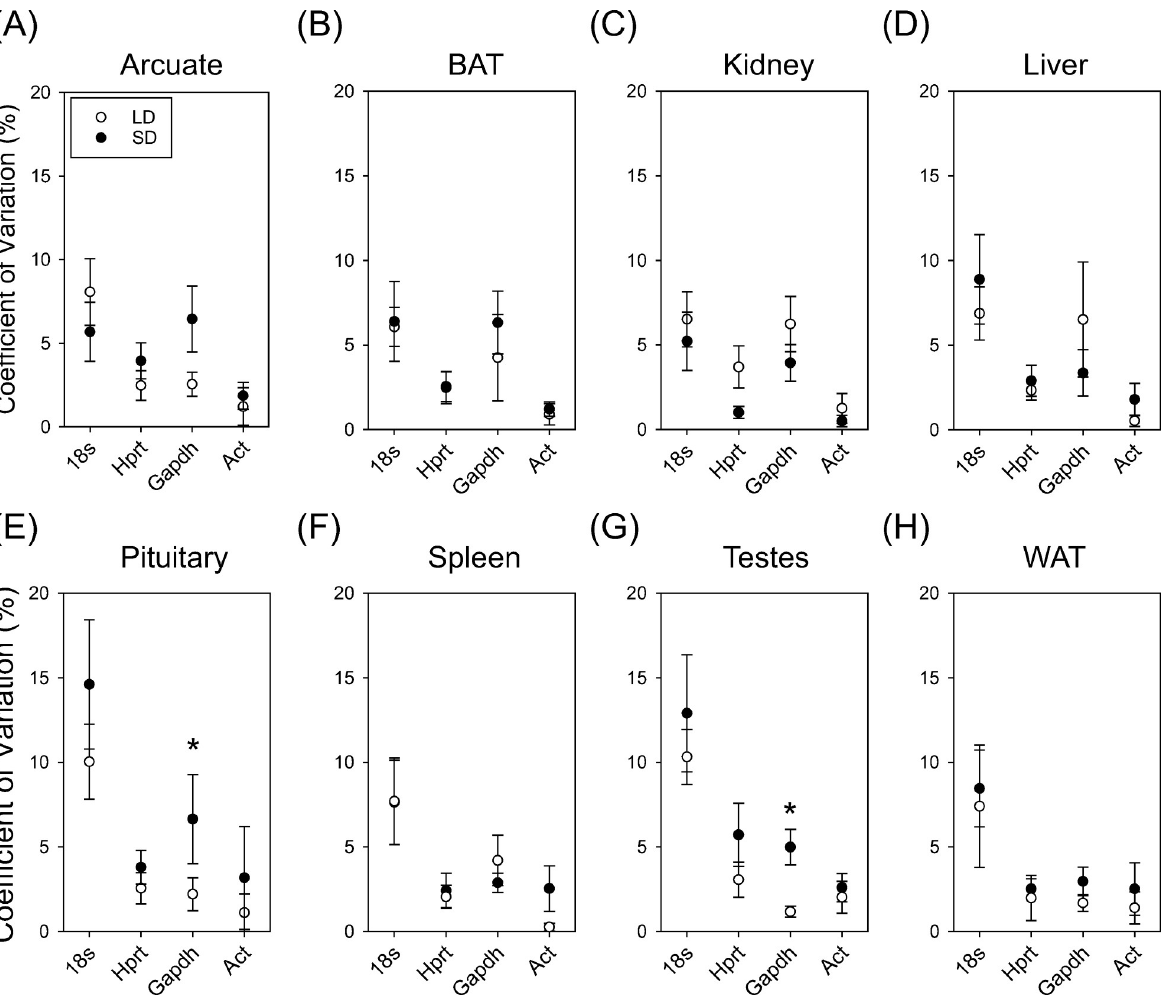
Fig 4. Coefficient of variation of expression efficiency of 18s, Hprt, Gapdh and Act in hamster tissues across photoperiod conditions. Mean coefficient of variation (CV%) of 18s, Hprt, Gapdh and Act in arcuate (A), BAT (B), kidney (C), liver (D), pituitary (E), spleen (F), testes (G) and Wat (H). Asterix indicates pairwise significant difference at P <